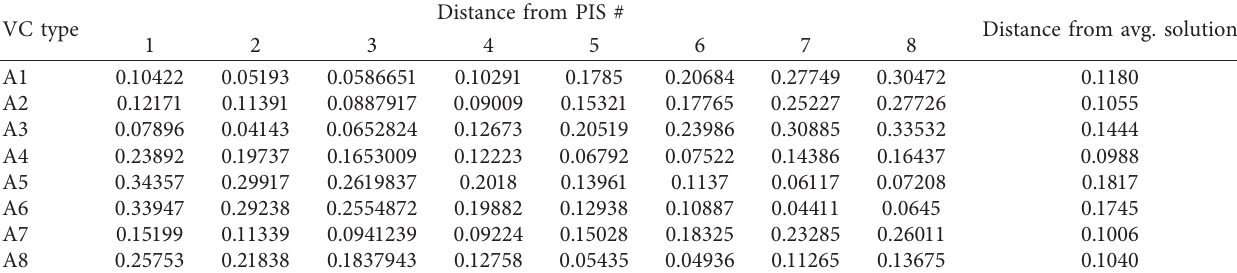
Table 13: Distance values of each alternative from the PIS and average solution.